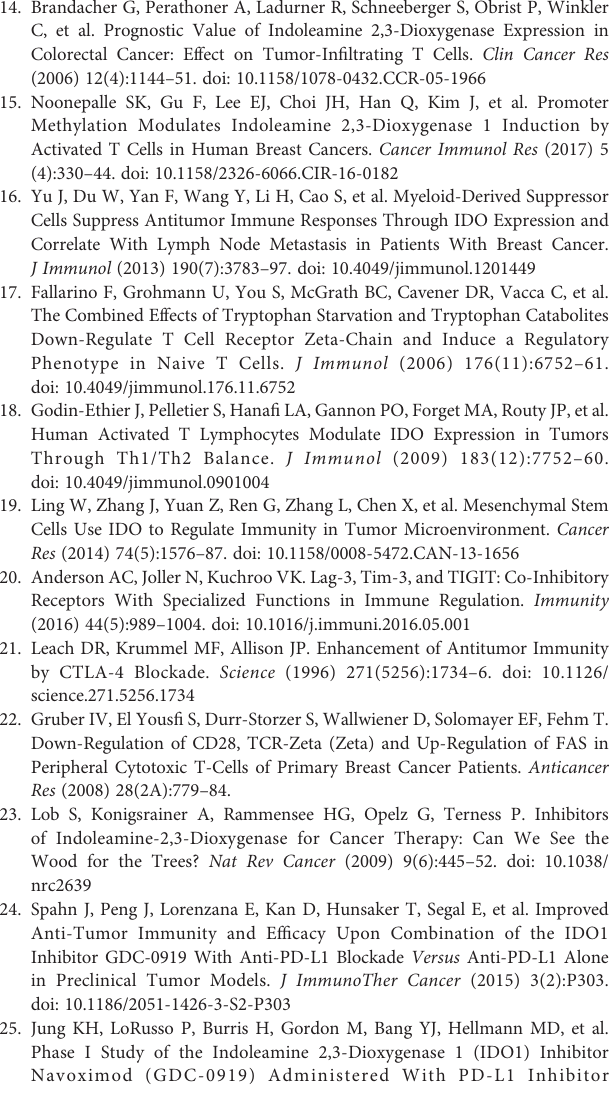
Supplementary Figure 7 | 1-MT treatment did not promote NKG2D expression of V g 9V d 2 T cells stimulated with MDA-MB-231 cells or MCF-7 cells. Human V g 9V d 2 T cells co-cultured with MCF-7 or MDA-MB-231 cells were treated with 1-MT (500 m M) or vehicle for 6 hours. Expression of NKG2D on V g 9V d 2 T cells from healthy donors was shown( n =3). Data representedmean ± SD; unpairedStudent ’ s t -test. Signi fi cance was set to P < 0.05 and represented as * P < 0.05, ** P < 0.01, *** P < 0.001, and **** P < 0.0001, n.s. , not signi fi cant. Supplementary Figure 8 | MICA/B levels on MDA-MB-231 and MCF-7 cells. Representative histograms of MICA/B expression by MCF-7 (luminal A) and MDA- MB-231 (TNBC)